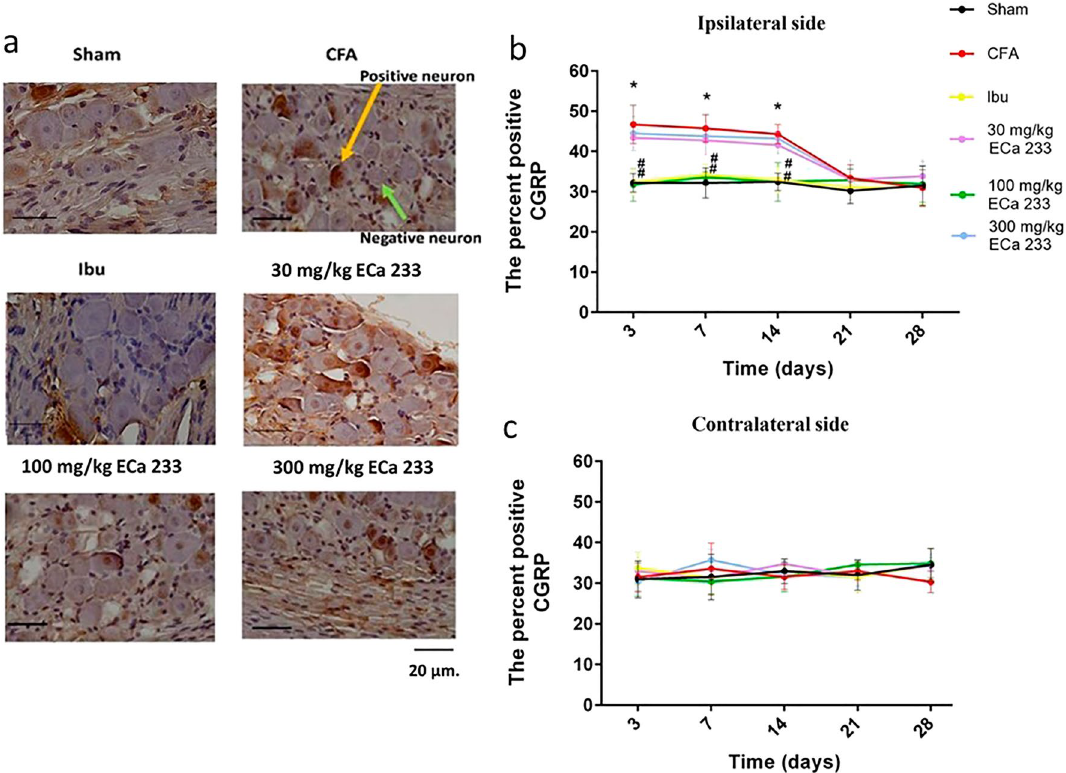
Figure 4. Calcitonin gene-related peptide (CGRP) expression in TGs in all groups at different time points. ( a ) An example of CGRP staining by immunohistochemistry at the ipsilateral trigeminal ganglia (TG) at post–CFA-injection day 3, scale bar = 20 µm. ( b , c ) Percentage of positive CGRP neurons per the total number of neurons in different groups. The CGRP expression in the complete Freund’s adjuvant–treated (CFA) group increased in the ipsilateral TG at post–CFA-injection days 3 [F(5,48) = 17.046, P < 0.05], 7 [F(5,48) = 16.046, P < 0.05], and 14 [F(5,48) = 15.048, P < 0.05] compared with that in the Sham group. Likewise, the CGRP expression in the groups treated with ibuprofen and 100 mg/kg ECa 233 (Ibu and 100ECa groups, respectively) significantly decreased in the ipsilateral TG at post–CFA-injection days 3 (Ibu [F(5,48) = 16.541, P < 0.05], 100ECa [F(5,48) = 17.291, P < 0.05]), 7 (Ibu [F(5,48) = 13.421, P < 0.05], 100ECa [F(5,53) = 14.913, P < 0.05]), and 14 (Ibu [F(5,48) = 13.421, P < 0.05], 100ECa [F(5,53) = 15.931, P < 0.05]), compared with that in the CFA group. In contrast to Ibu and 100ECa groups, the 30ECa and 300ECa groups could not show the decreased CGRP expression (day 3: 30ECa [F(5,48) = 33.541, P = 0.254], 300ECa [F(5,48) = 40.129, P = 0.354]; day 7: 30ECa [F(5,48) = 32.134, P = 0.265], 300ECa [F(5,48) = 41.229, P = 0.334]; day 14: 30ECa [F(5,48) = 31.334, P = 0.255], 300ECa [F(5,48) = 40.091, P = 0.374]). In the contralateral TG, the CGRP expression did not change by CFA on any days (day 3: [F(5,48) = 31.254, P = 0.220]; day 7: [F(5,48) = 30.324, P = 0.213]; day 14: [F(5,48) = 33.424, P = 0.296]). (mean ± SEM; n = 3/group/time point; *P < 0.05 compared with the Sham group, # P < 0.05